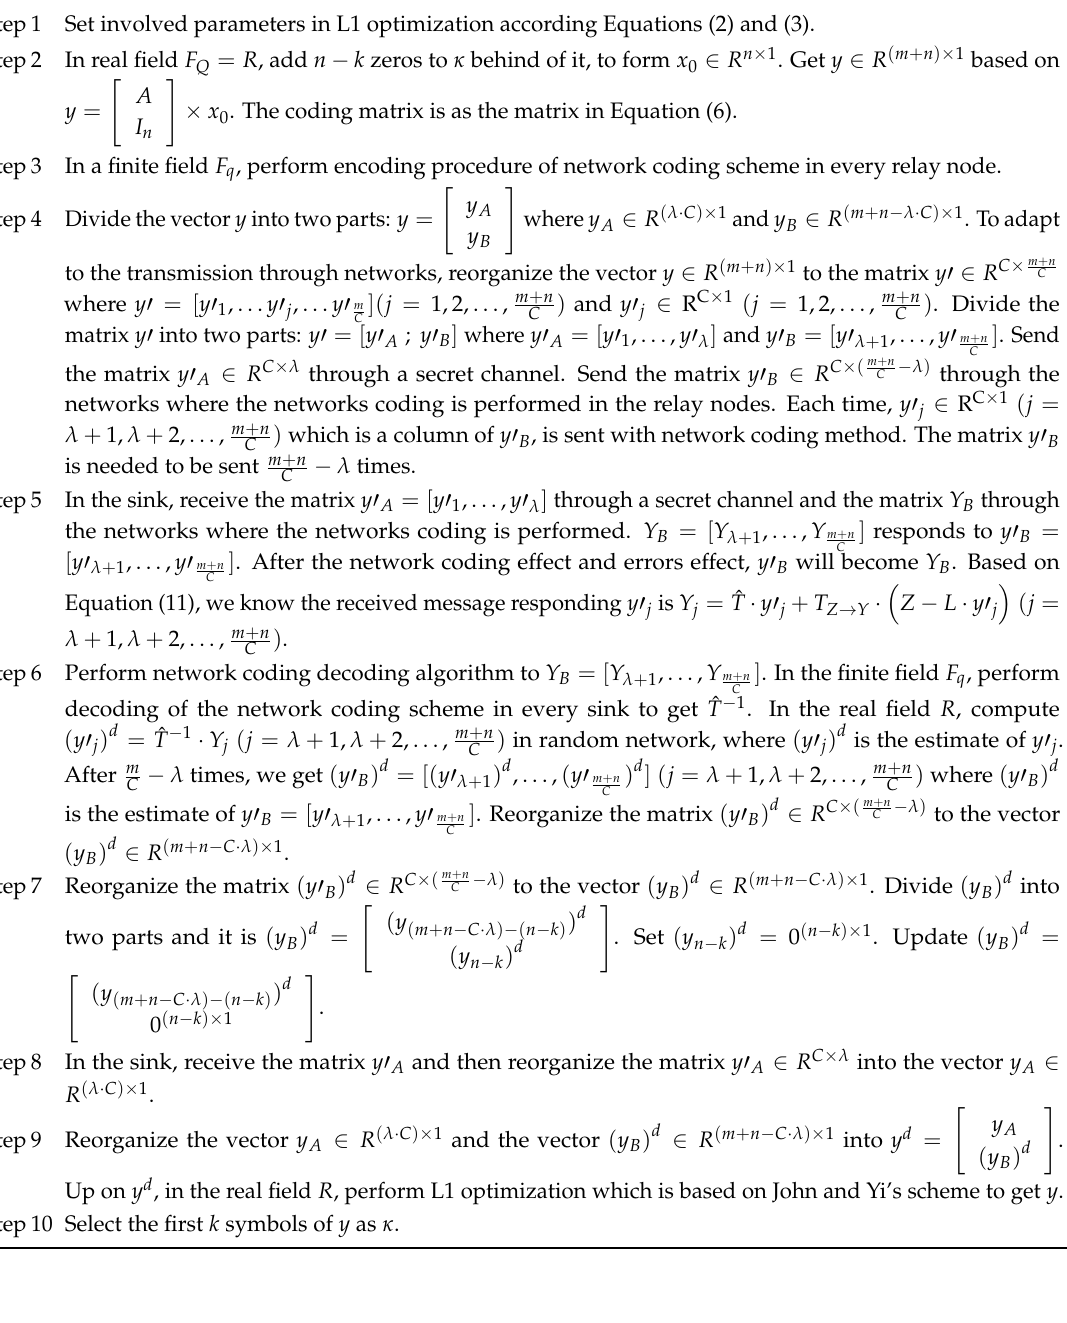
Algorithm 1. LOECNC